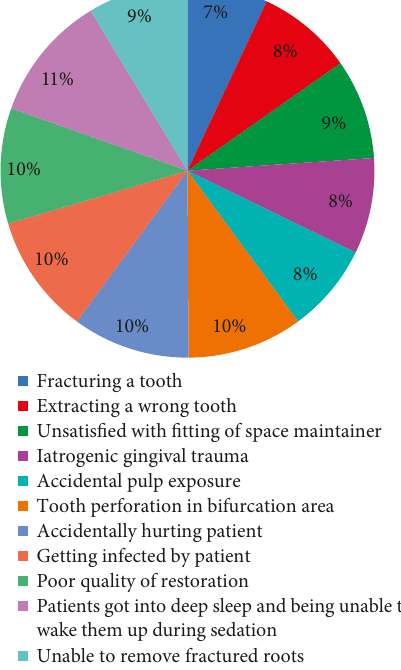
Figure 5: Level of anxiety during clinical